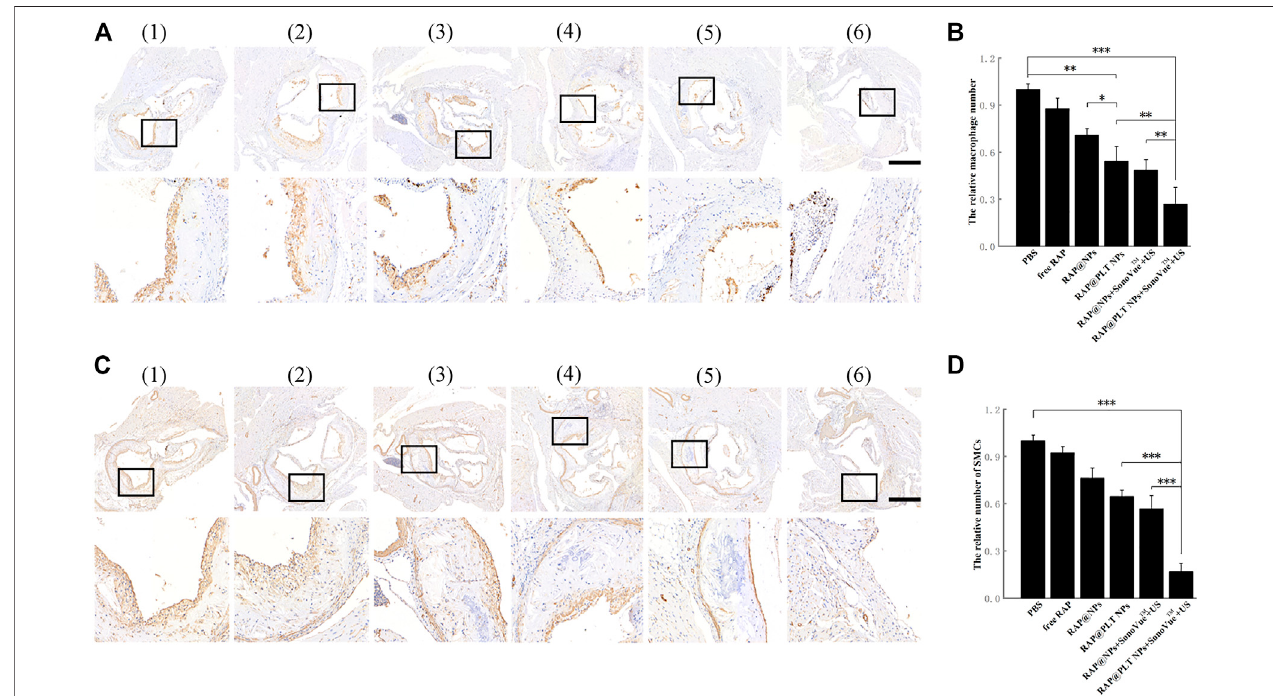
FIGURE9| ImmunohistochemistrystainingofaorticrootsectionsfromApoE − /- miceafterdifferenttreatmentatday30(Wangetal.,2021).-(CostaglioladiPolidoro et al., 2021) referred to (Wang et al., 2021) PBS (Libby, 2012),free RAP (Shapiro and Fazio, 2016),RAP@NPs(Moriya, 2019),RAP@PLT NPs (Winkel et al., 2014), RAP@ NPs + SonoVue ™ + US (Costagliola di Polidoro et al., 2021), RAP@PLT NPs + SonoVue ™ + US. Representative images of immunohistochemistry staining